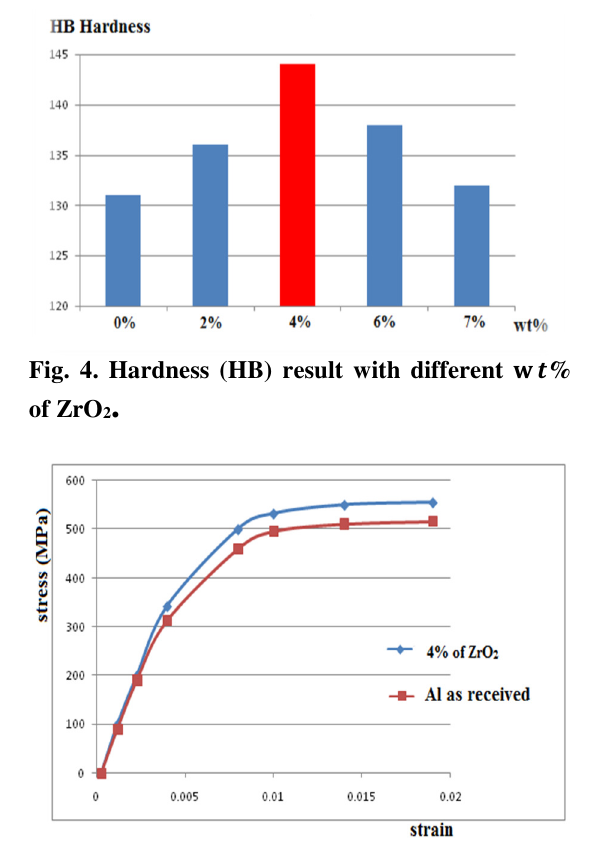
Fig. 5. Tensile test for 7049AA and Nano composite with 4 (cid:11) (cid:20) % of ZrO 2 . Improvement fatigue life factor (IFLF) at different amplitude stress.